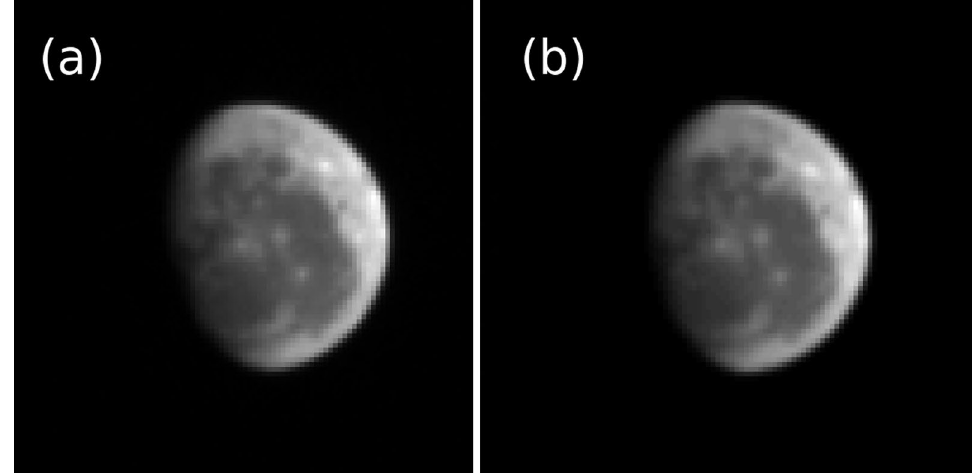
Fig. 9 a Lunar image obtained by ONC-T (v band) on December 6, 2020 and b simulated image calculated by the SP model (Yokota et al. 2011)